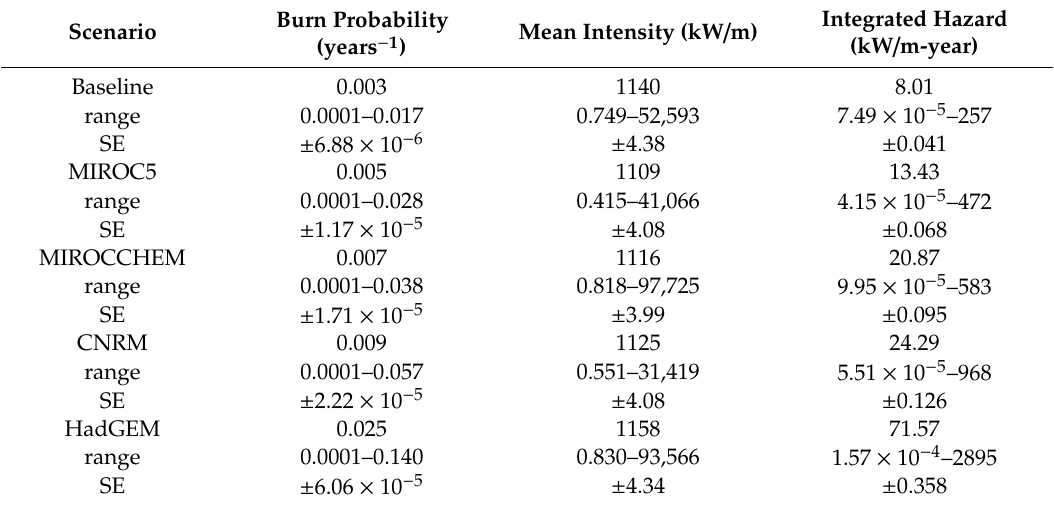
Figure 7. Burn probability and mean fireline intensity at each pixel in the study area under baseline (gray) and future scenarios (red). Diagonal lines demarcate integrated wildfire hazard classes. Table 4. Watershed-wide average integrated wildfire hazard and hazard components under each climate scenario. Range and standard error are shown below each average value.